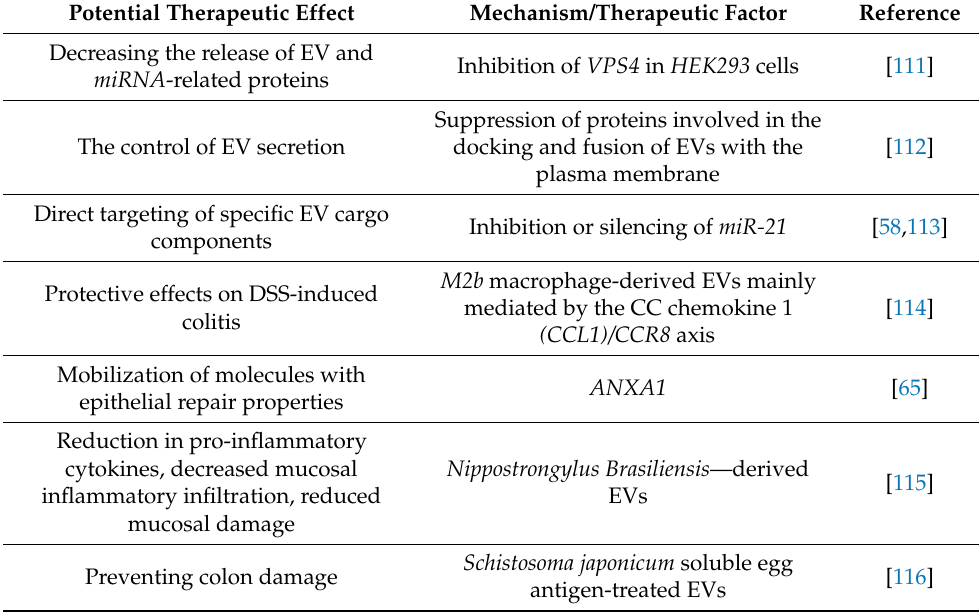
Table 2. Potential of EVs in clinical